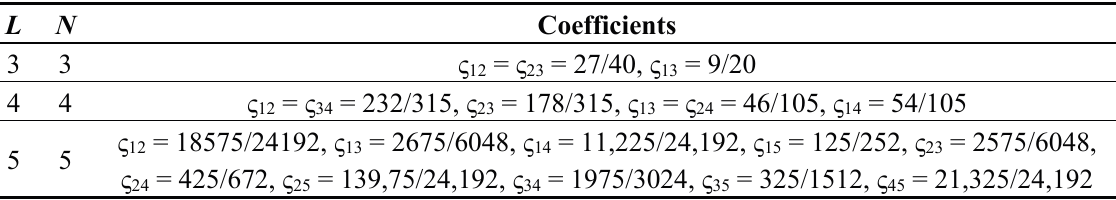
Old Table 9. FTSuc algorithm